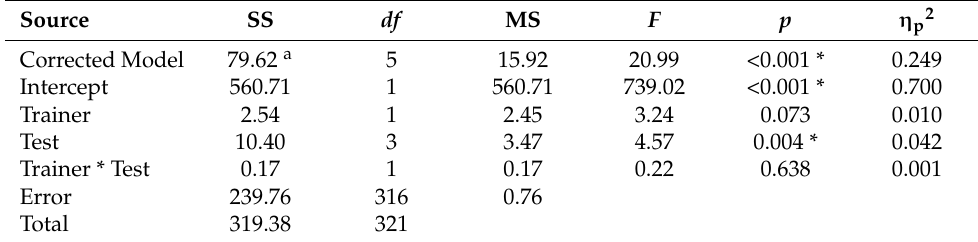
Table 5. Two-way ANOVA for grief-informed techniques by trainer and test type ( n = 321).